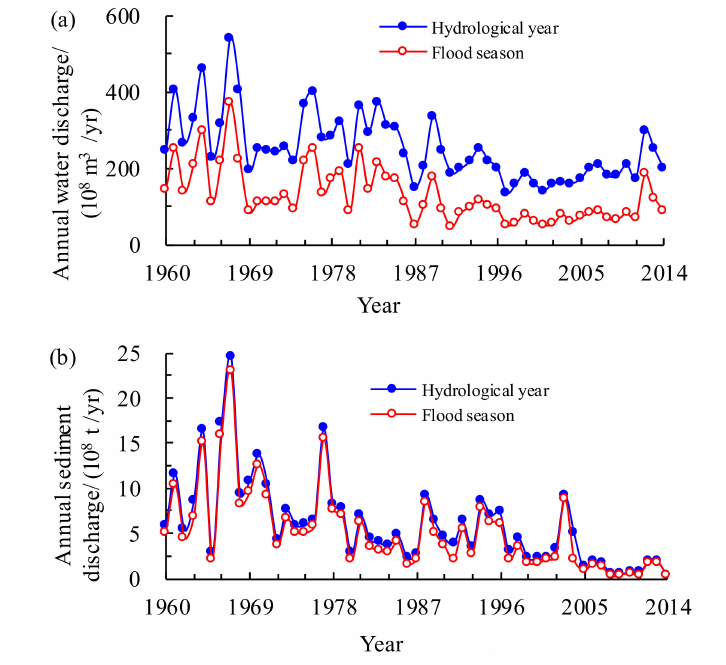
Figure 2. Temporal variations in the flow and sediment regime entering the Xiaobeiganliu reach: ( a ) annual water discharge; ( b ) annual sediment